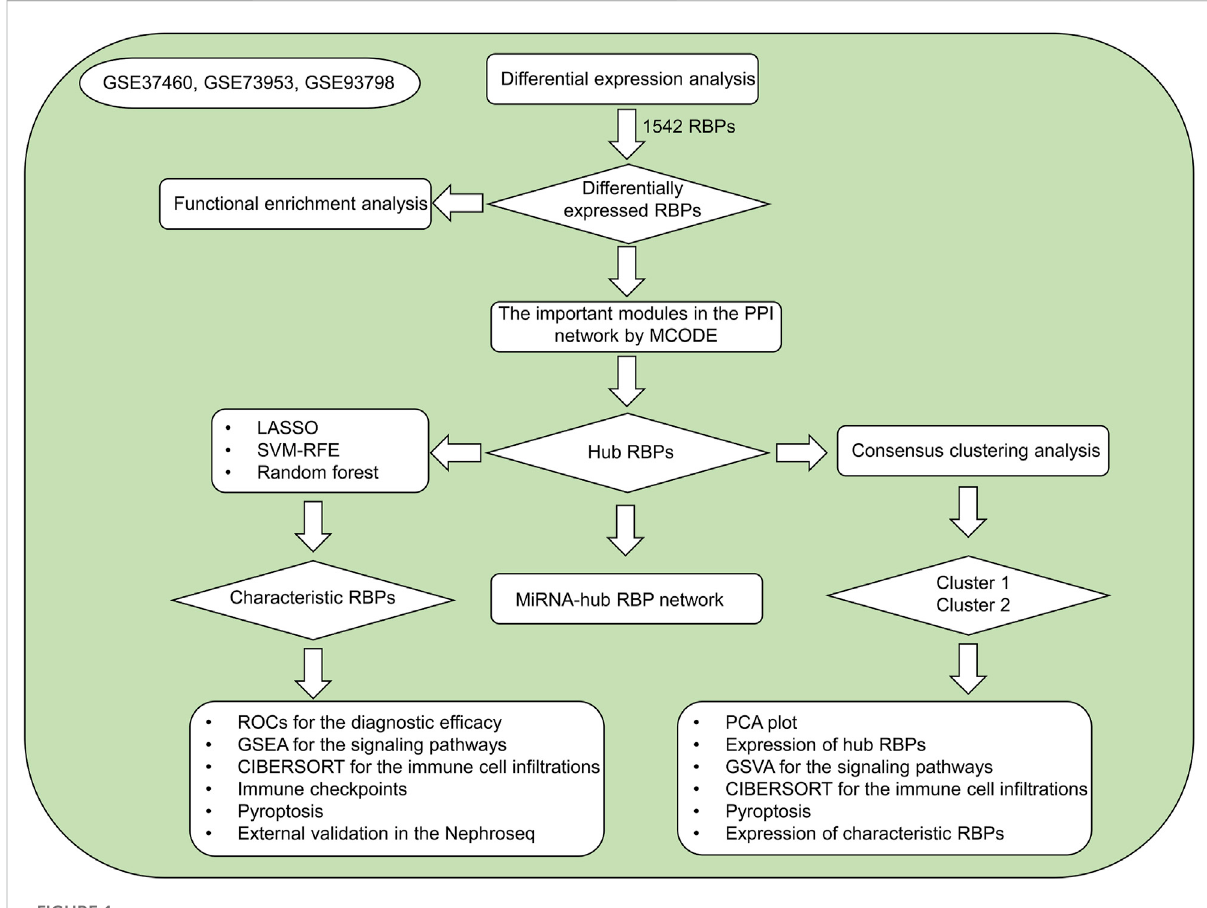
FIGURE 1 The overall fl owchart of our